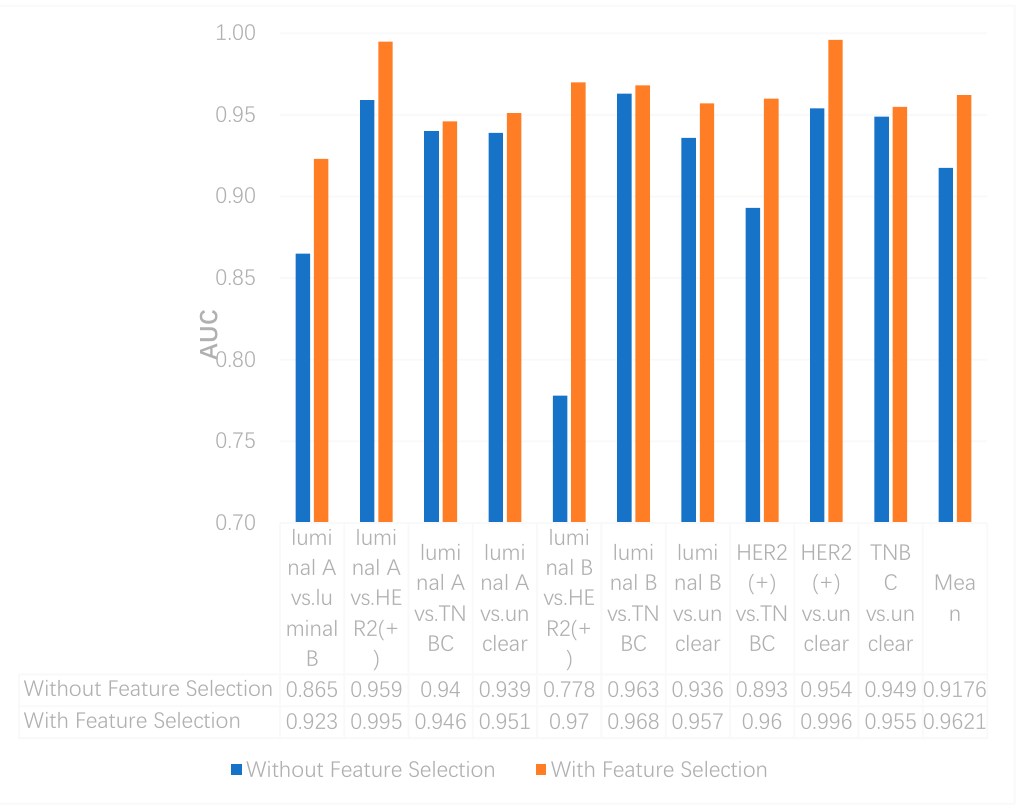
Figure 7. The accuracy of multi-omics data integration using deep neural networks with and without feature selection.